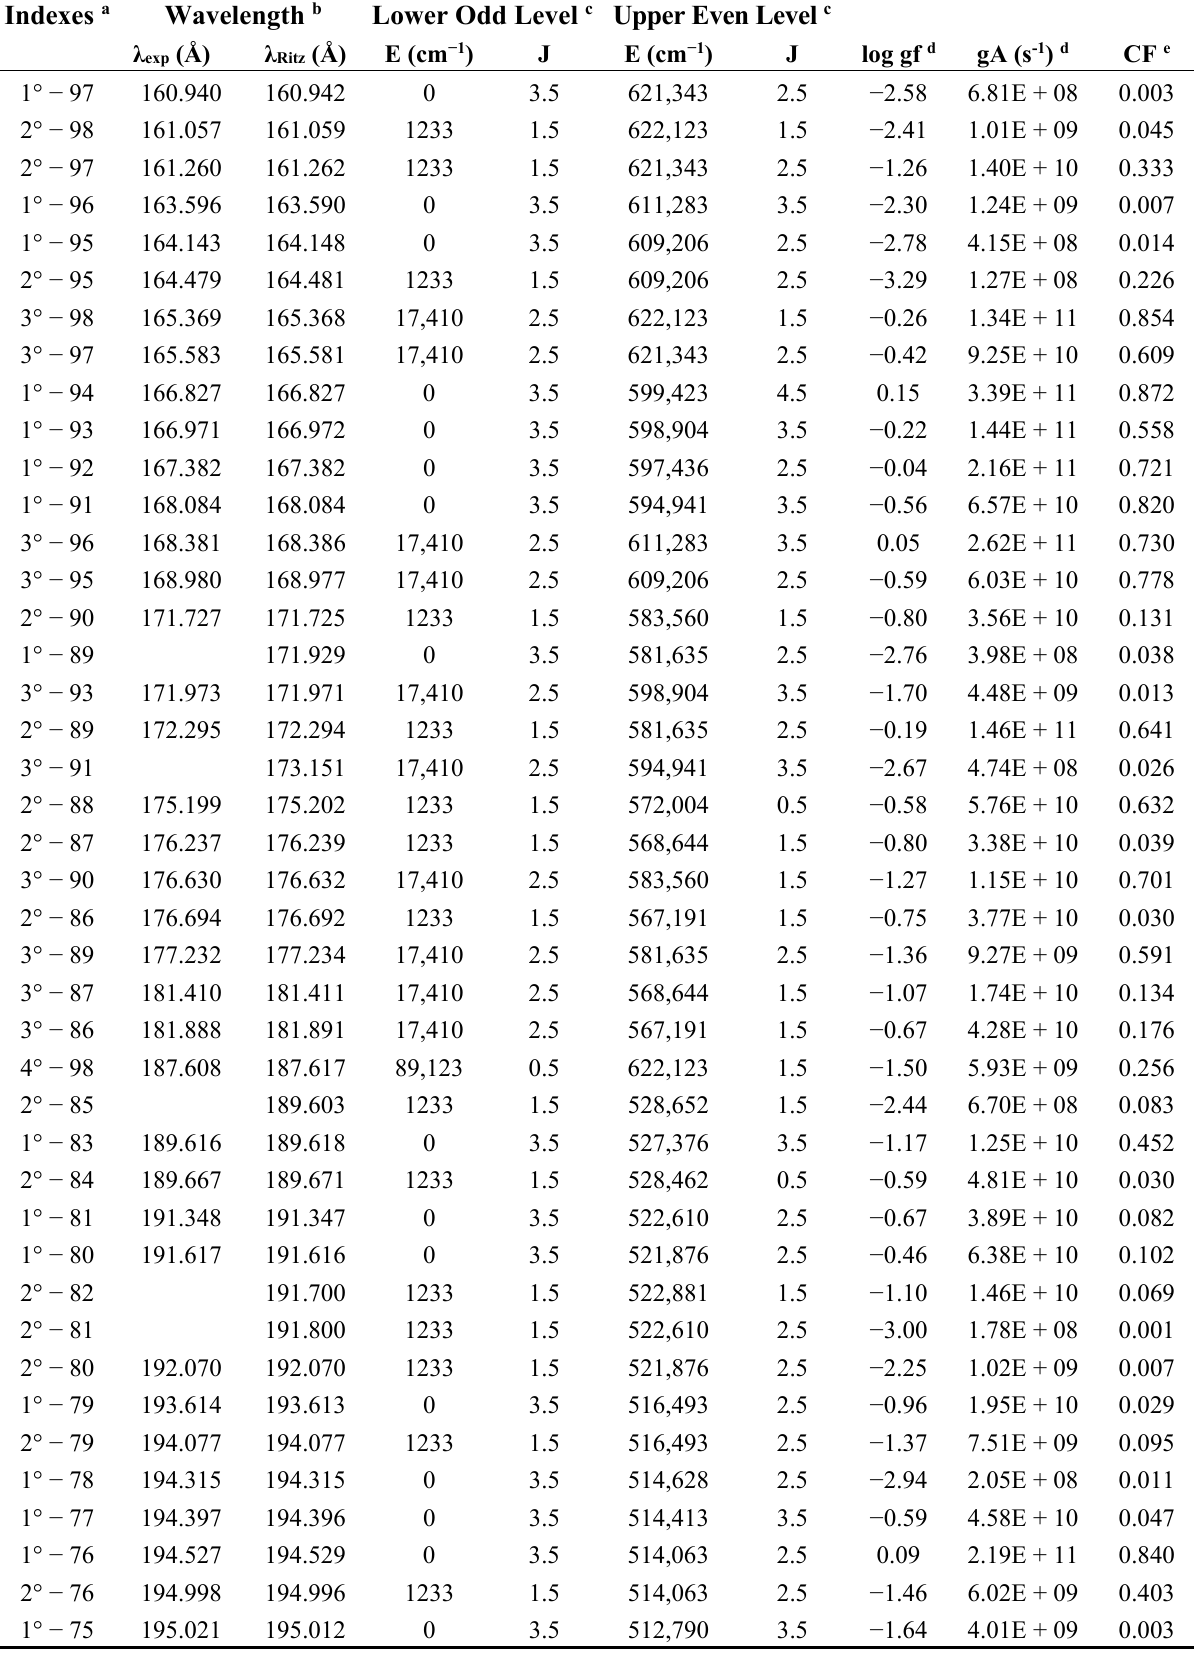
Table 3. Oscillator strengths and transition probabilities in W VIII (log gf > − 4). A table entry 6.81E + 08 means 6.81×10 8